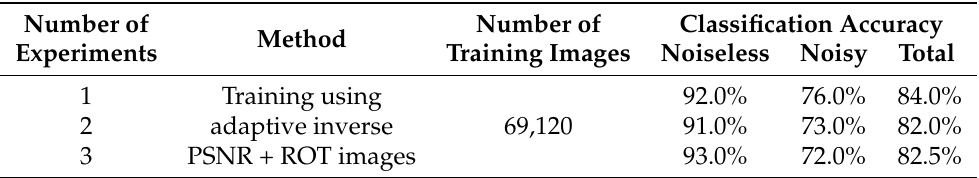
Table 6. Classification accuracy of the network trained using images obtained by the adaptive inverse PSNR and RGB color space and